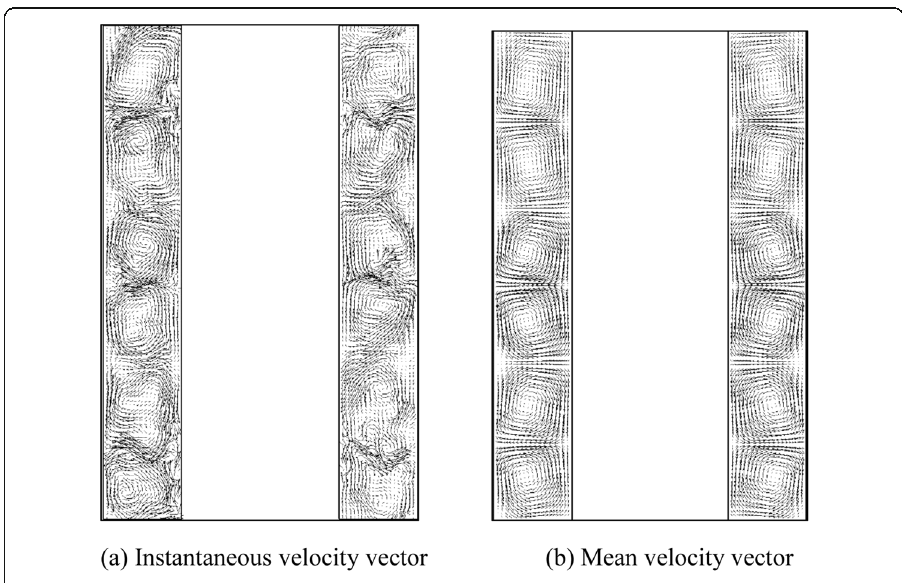
Fig. 10 Instantaneous and mean velocity vector plots on the y = 0